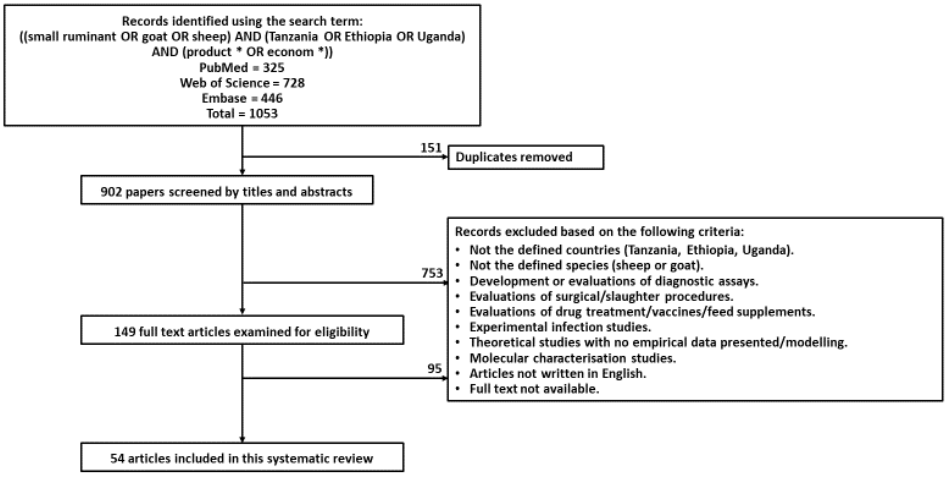
Figure 1. Flowchart for the systematic review to identify eligible articles to determine the constraints influencing small ruminant production.